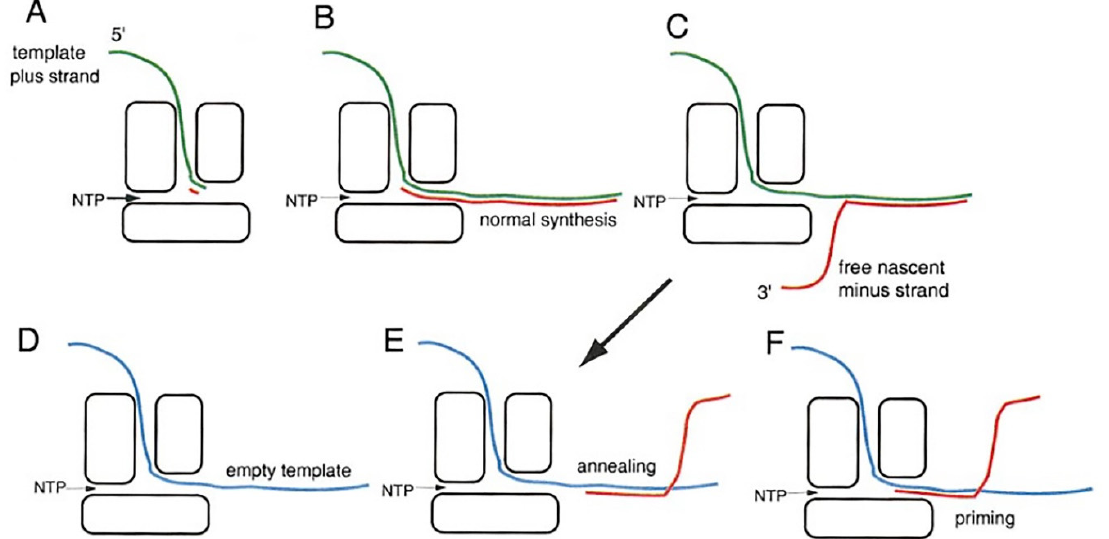
Figure 11. Proposed model for the process of template switching recombination in ϕ 8. Normally, the 3 ′ end of the template plus strand (green) enters the polymerase and is arrested near the site of nascent minus ‐ strand chain formation ( A ); as the minus strand (red) is synthesized the dsRNA leaves the polymerase through the exit pore ( B ). The 3 ′ end of the nascent chain can be displaced from the template ( C ). It can reanneal to the template, or it can anneal to an empty template (blue) ( E ). A plus ‐ strand RNA that does not have a proper 3 ′ end can enter the polymerase, but the template is not arrested at the catalytic site ( D ). Instead, it passes through the polymerase and can scan backward and forward. When a nascent minus strand anneals to the empty template and the template moves back into the polymerase, the nascent chain can act as a primer to start minus ‐ strand synthesis on the empty template ( F ). The result is a recombinant minus strand. Reproduced from Onodera et al. (2001).